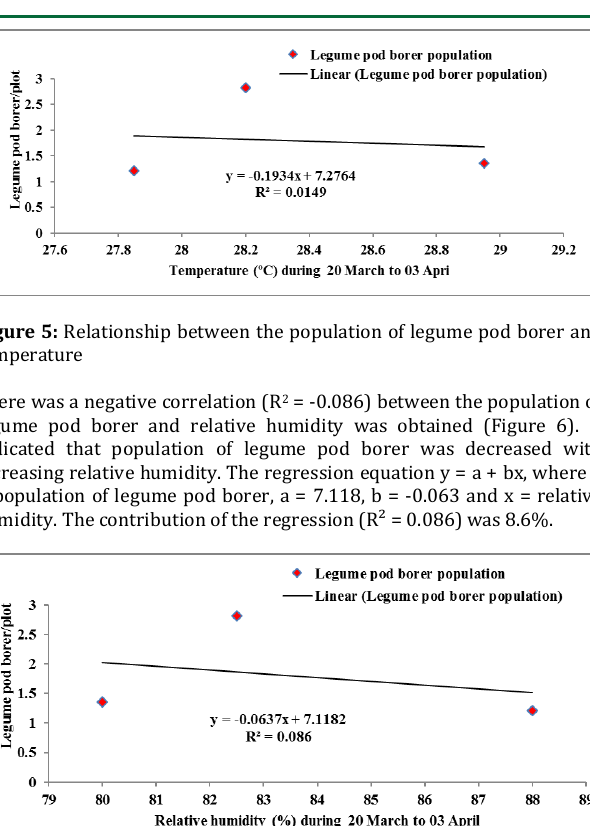
There was a negative correlation (R 2 = -0.014) between the population of legume pod borer and temperature. It indicates that the population of legume pod borer was decreased with increasing temperature. A linear regression was fitted between temperature and population of legume pod borer (Figure 5). The regression equation y = a + bx, where y = population of legume pod borer, a = 7.276, b = -0.193 and x = temperature. The contribution of the regression (R² = 0.014) was 1.4%.